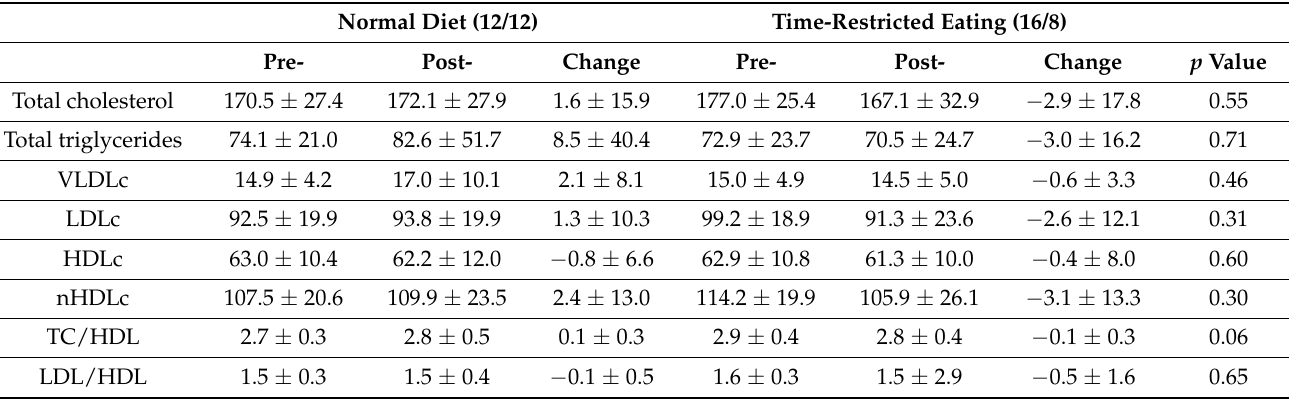
Table 8. Cardiovascular Disease Risk Markers: Lipids and Lipoproteins 1